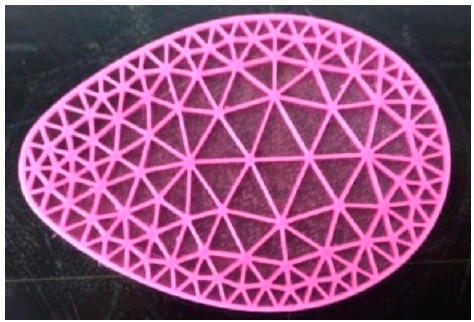
Figure 10. Example of a heel zone insert printed without top lid (solely intended to show its internal structure).